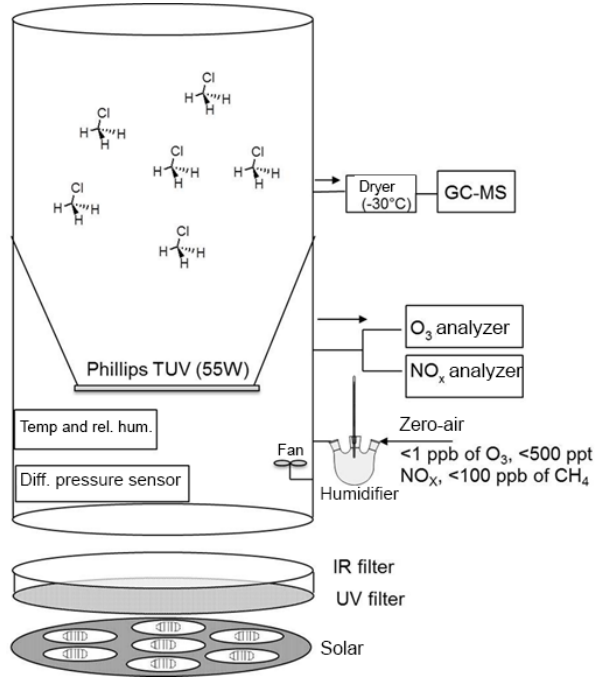
Figure 1. Schematic of the experimental smog